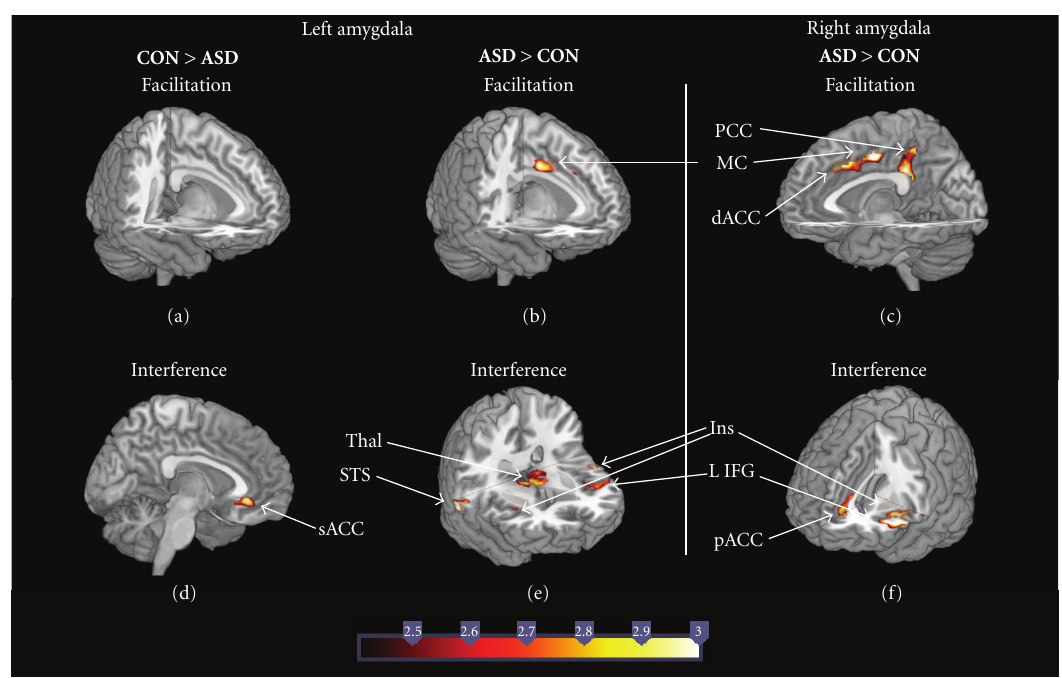
Figure 3: Regions showing di ff erences between ASD and control children for left and right amygdala connectivity during facilitation (Congruent > Neutral) and interference (Incongruent > Neutral). In control children, only left amygdala showed increased connectivity relative to ASD in interference (d), while ASD showed increased connectivity in both amygdalae relative to controls during both facilitation (b) and (c), and interference (e) and